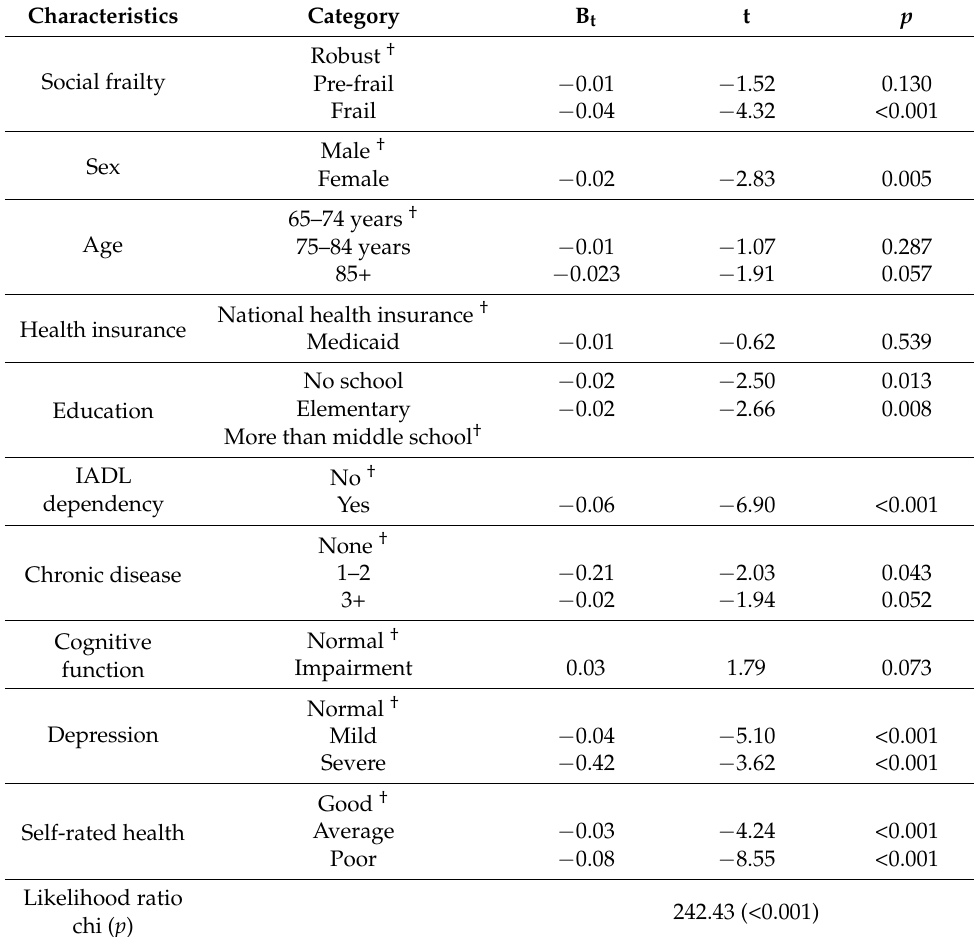
Table 4. Influencing factors on the health-related quality of life; N =